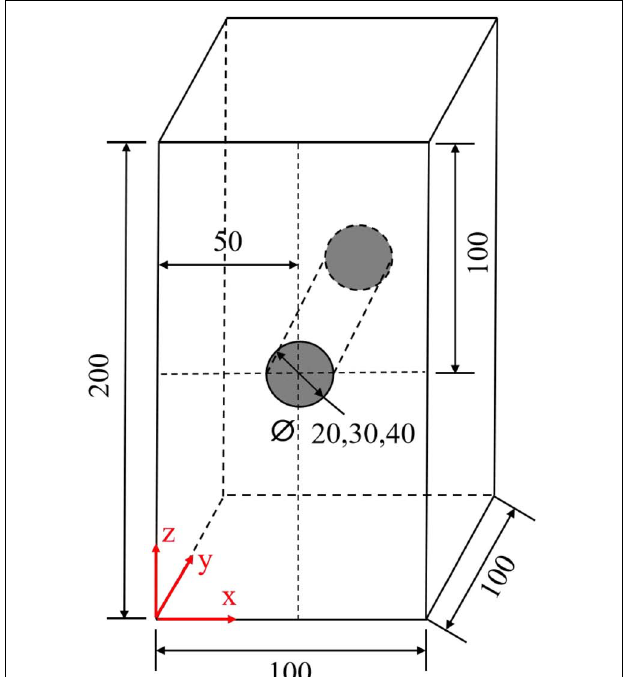
FIGURE 2 | Sample model containing a single circular cavity (unit: